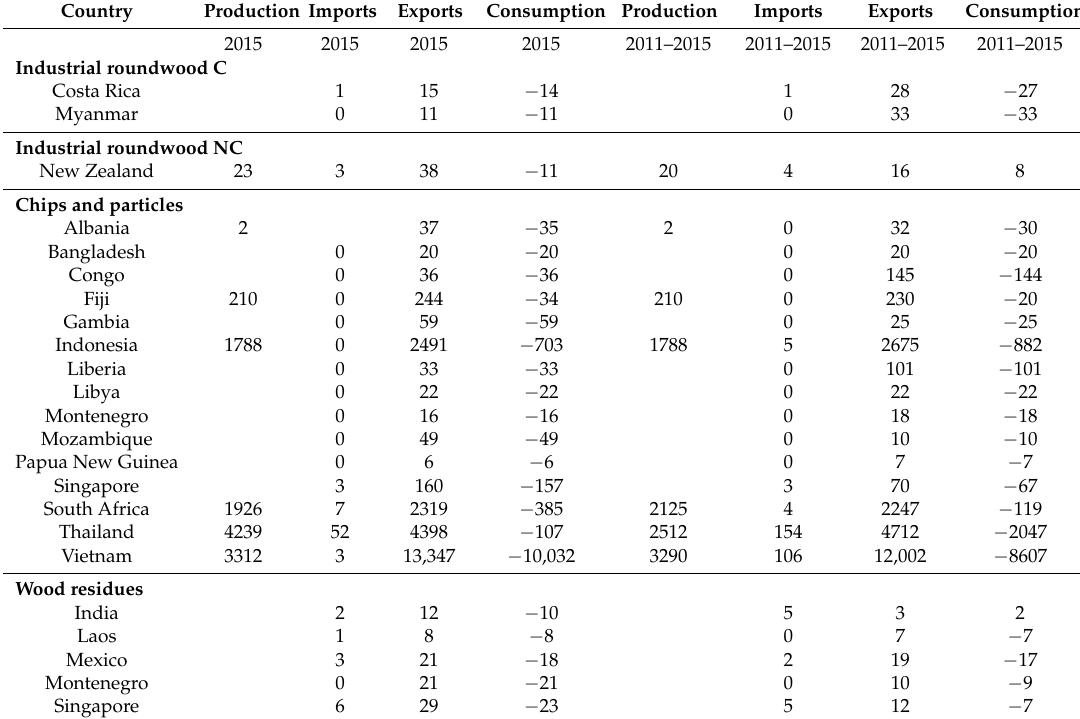
Table 3. Annual productions, exports, imports, and apparent consumption of industrial roundwood and wood residues in 2015 and in the period of 2011–2015 on average (1000 m 3 ). Only countries